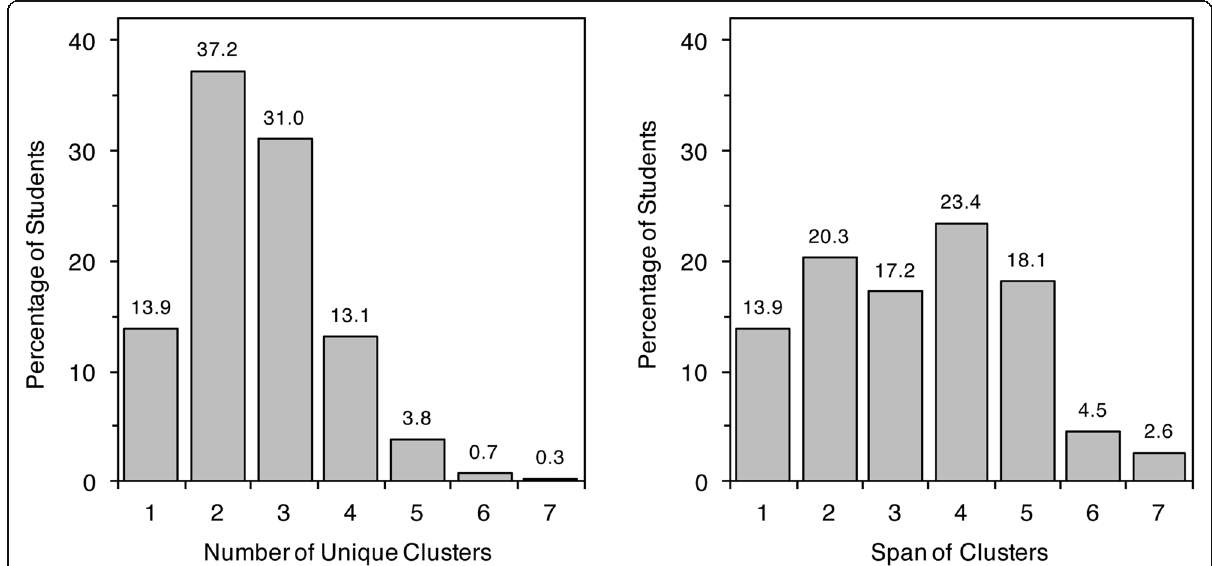
Fig. 5 Situational motivation stability and transition indicators for individuals with at least five responses to the weekly motivation survey. The left graph shows the percentages of students who reported n unique motivation response profiles (clusters). The right graph shows percentages of students who transitioned different distances across the cluster profiles. A span of 1 on the right graph represents individuals with cluster membership that did not change; a span of 3 indicates a shift from Cluster AU to Cluster ID-EX, from cluster EX to Cluster M-ID,